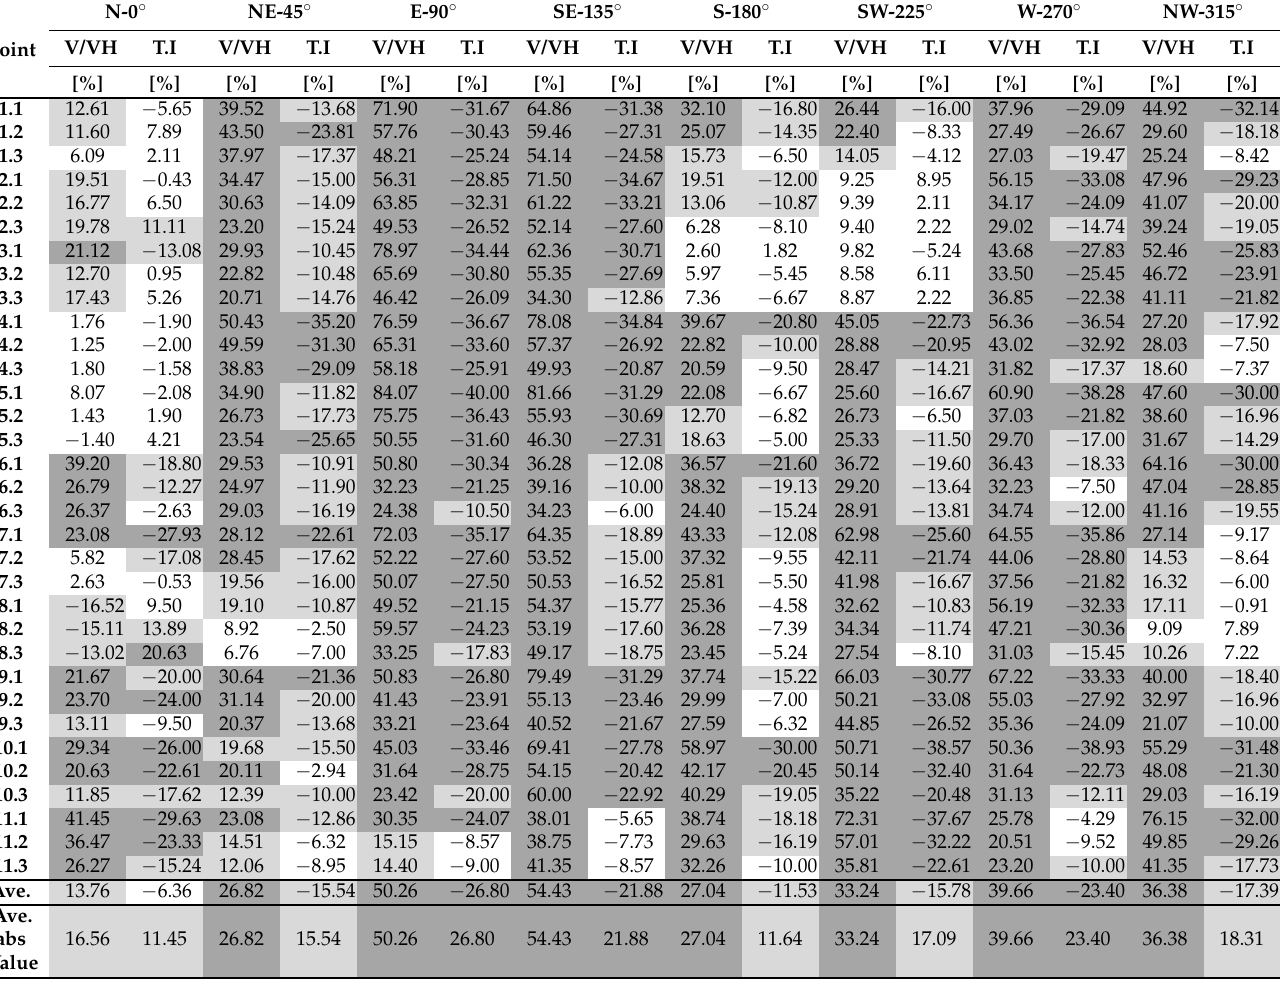
Table 5. Deviation results obtained from the WAsP Engineering model. V/VH is the ratio between velocity (V) and velocity at the top of the boundary layer achieved by the model (VH); TI is the turbu- lence intensity. Values shadowed by dark grey represent deviations with values ≥ 20% or ≤ − 20% while values shadowed by light grey color represent deviation values ≥ 10% or ≤− 10% and no shadowed values have deviation values > − 10% or values < 10%. Points denoted by .1 or .2 or .3 mean height above ground at 9 m, 12 m, and 17 m,